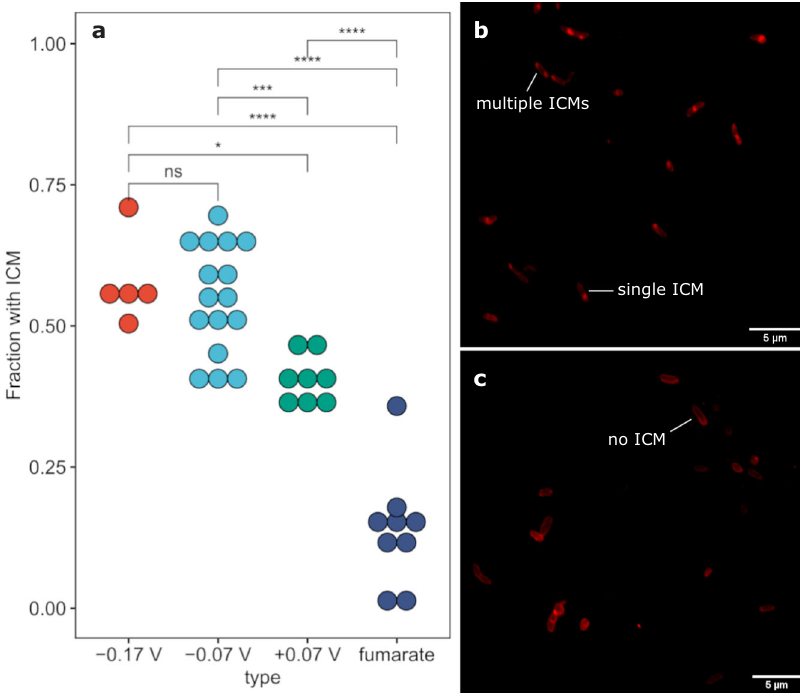
Fig. 4 ICM frequency in G. sulfurreducens measured by confocal microscopy. a Fraction of cells with an ICM in G. sulfurreducens under different growth conditions. Each dot represents a unique image with an average of 113 cells, see Supplemental Table 1 for raw counts. The three potentials – − 0.17, − 0.07, and + 0.07 – represent cells collected from anodes poised at the respective potentials vs. SHE. The ‘ fumarate ’ condition cells were grown planktonically with fumarate as the electron acceptor. Statistical testing consisted of a two-tailed t-test with Hochberg multiple comparison correction. *( ρ < 0.05), ***( ρ ≤ 0.001), ****( ρ ≤ 0.0001). b Sum projection of confocal z-stacks of G. sulfurreducens cells grown on an electrode at -0.07 V vs. SHE with examples of ICM annotated. c Sum projection of cells grown with fumarate as an electron acceptor exemplifying typical cell morphology when ICM is not present. Both cell images were cropped from larger images taken at 100X magni fi cation using Nile red as a phospholipid-selective fl uorophore. See zoomed insets in Supplemental Fig.